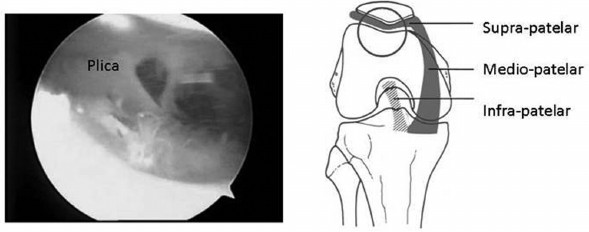
Figure 4 – Arthroscopic image of a supra-patellar synovial plica. The patella can be seen above the femoral trochlea. In the drawing, the circle demon- strates the position of the